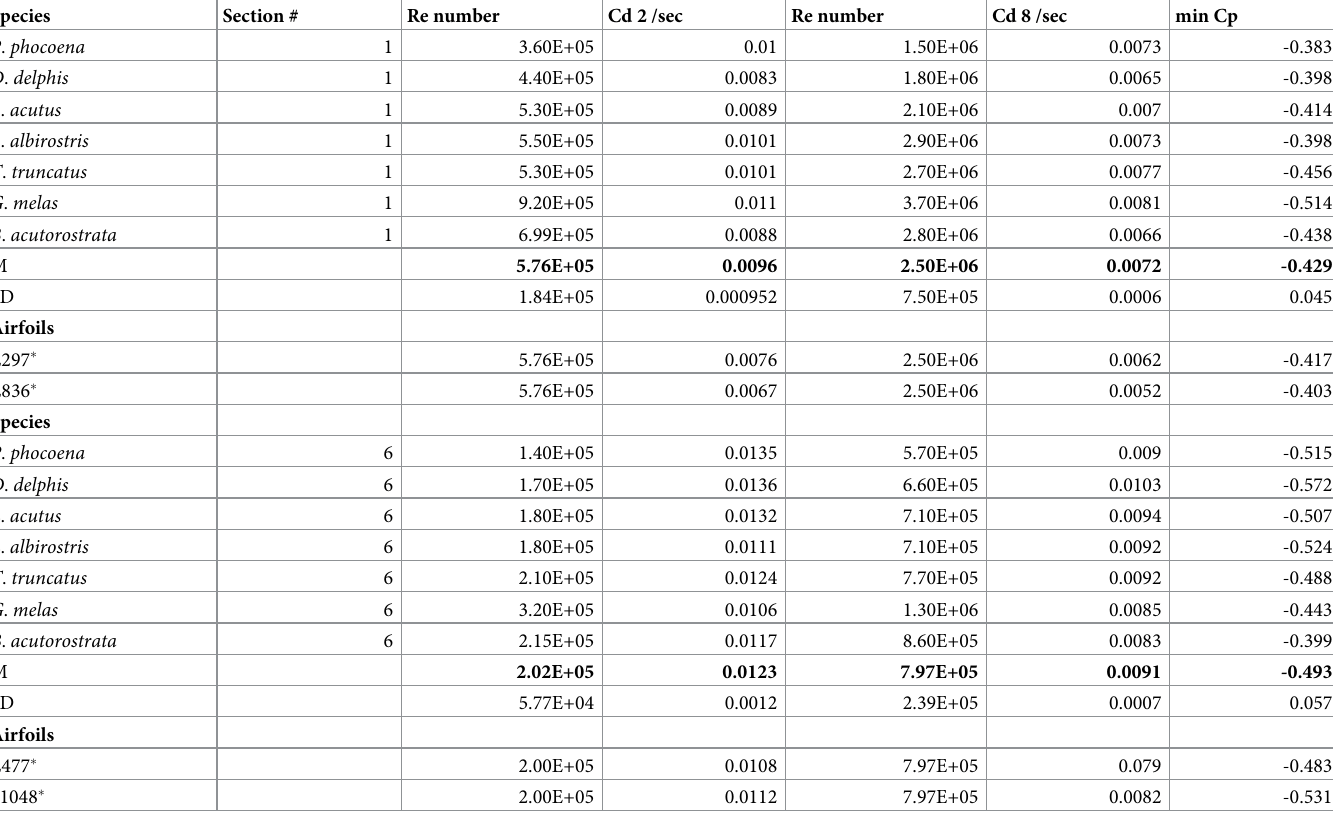
(S14 Fig). Cross-sections located at the base of the fin as well as the 297 and 836 airfoils had compara- ble average values of Cd calculated for α = 0˚ (Table 9). Pressure distribution had a sharp nega- tive pressure gradient at the leading edge with minimal Cp values at 15–20% of the chord length. Both in the cross-sections and airfoils, the region from 20 to 60% of the chord length was characterized by zero or a slightly positive pressure gradient. The average values of Cd of cross-sections located at the tip of the fin were comparable with the Cd of 477 and S1048 Table 9. Comparison of the hydrodynamic characteristics of the dorsal fin cross-sections with the appropriate airfoils. Species Section # Re number Cd 2